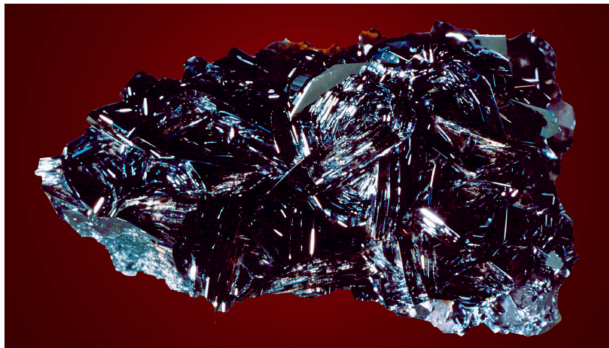
Figure 12. Hematite, Chub Lake prospect. 8 cm. Chamberlain Collection, NYSM C12234. SC.